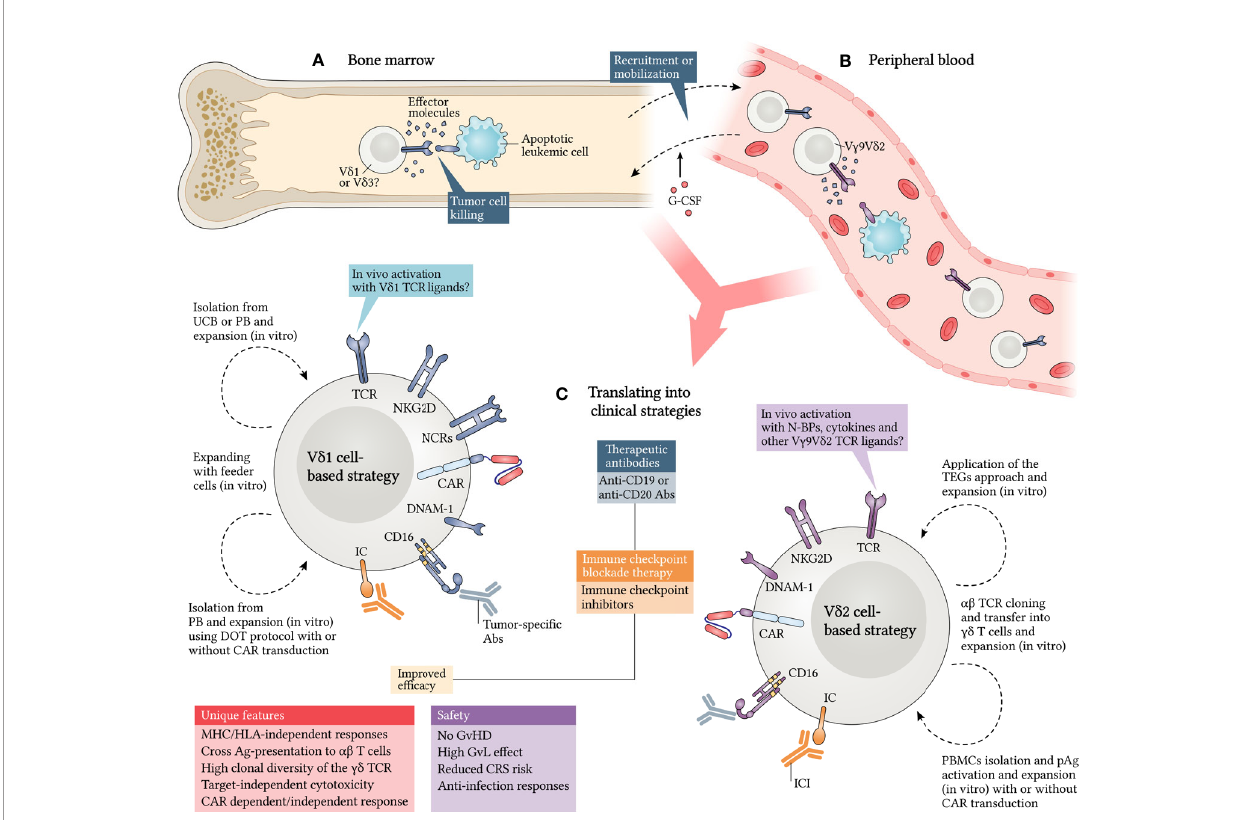
FIGURE 3 | Translating gd T cells into clinical strategies against leukemia. gd T cells exert antitumor responses in different compartments and expressing distinct TCR patterns. V d 1 and V d 3 subtypes have been implicated as cytotoxic mediators in bone marrow (A) , while V g 9V d 2 cells have been shown to respond mainly in peripheral blood (B) . However, strategies are directed towards V d 1 and V d 2 subtypes, as they are the best known (C) . Granulocyte colony-stimulating factor (G-CSF) was shown to be a potential adjuvant to mobilize gd T cells for peripheral blood and enrich the graft. Additionally, V d 1 cells can be isolated from UCB or PB and expanded in vitro using some approaches, such as the DOT protocol, already reviewed here. In vivo stimulation with V d 1 TCR ligands may be a good alternative, but it remains poorly investigated. In parallel, V d 2 cells can be isolated from PB and activated and/or expanded in vitro using pAgs. A new therapeutic concept consists in the cloning and transfer of gd TCRs into ab T cells (TEGs) and can enhance antileukemic responses. The fact is that many of these strategies give rise to gd T cells that express several recognition receptors and have a higher capacity to target leukemic cells (LC), which can be further improved with chimeric antigen receptor (CAR) transduction. Moreover, the use of therapeutic antibodies (Abs), such as immune checkpoint inhibitors (ICI), anti-CD19 and anti-CD20 Abs, can also provide improved ef fi ciency in potential approaches, since gd T cells have unique features and an attractive degree of safety for their translation into clinical trials. CRS, cytokine release syndrome; DOT, Delta One T; PB, peripheral blood; IC, immune checkpoint; TEGs, T cells engineered to express a de fi ned gd TCRs; UCB, umbilical cord